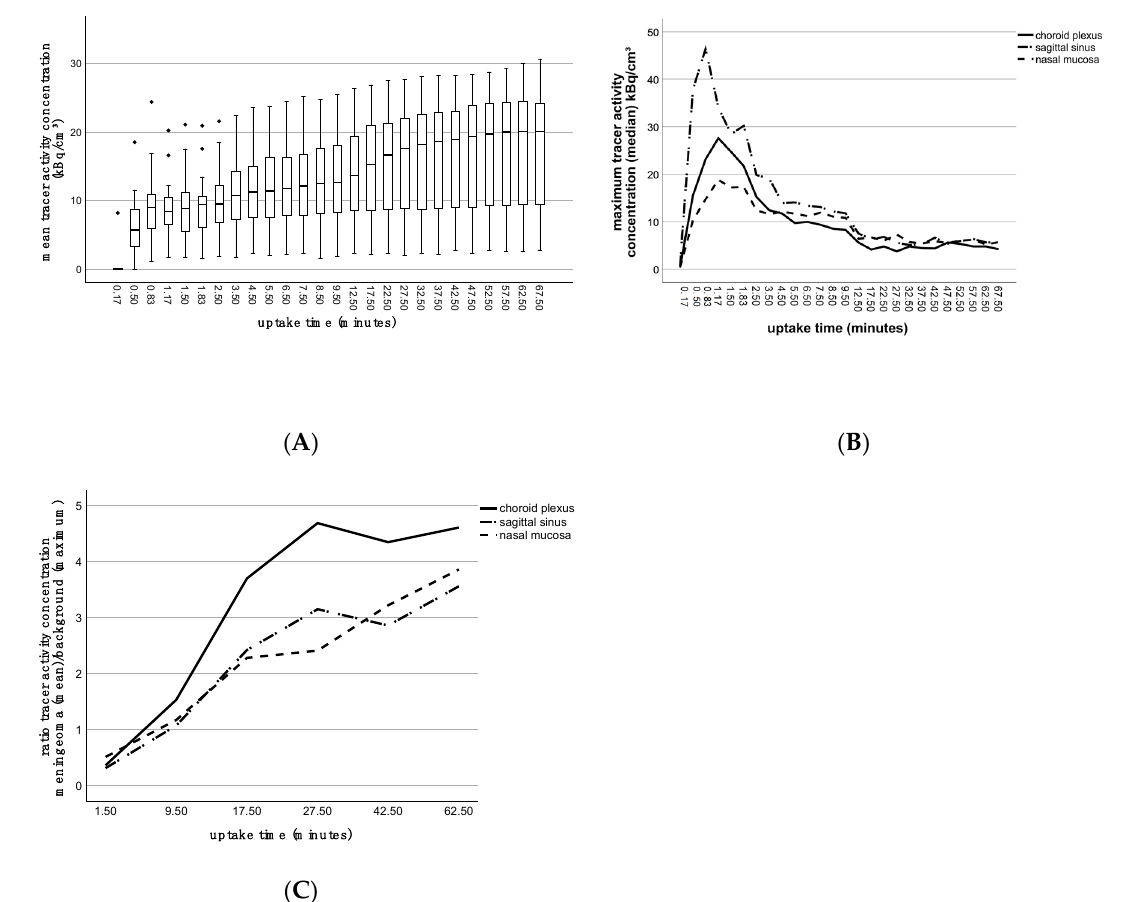
Figure 4. Tracer activity concentration, kinetics and ratios. ( A ) Box plots of mean tracer activity concentration (kBq / cm 3 ) of all meningiomas for each time point; ( B ) line diagram showing the maximum tracer activity concentration as the median (kBq / cm 3 ) of three di ff erent background regions as a function of uptake time; ( C ) line diagram depicting the median ratios of mean tracer activity concentration in meningioma lesions to maximum concentration in the backgrounds. Black dots represent the outliers.